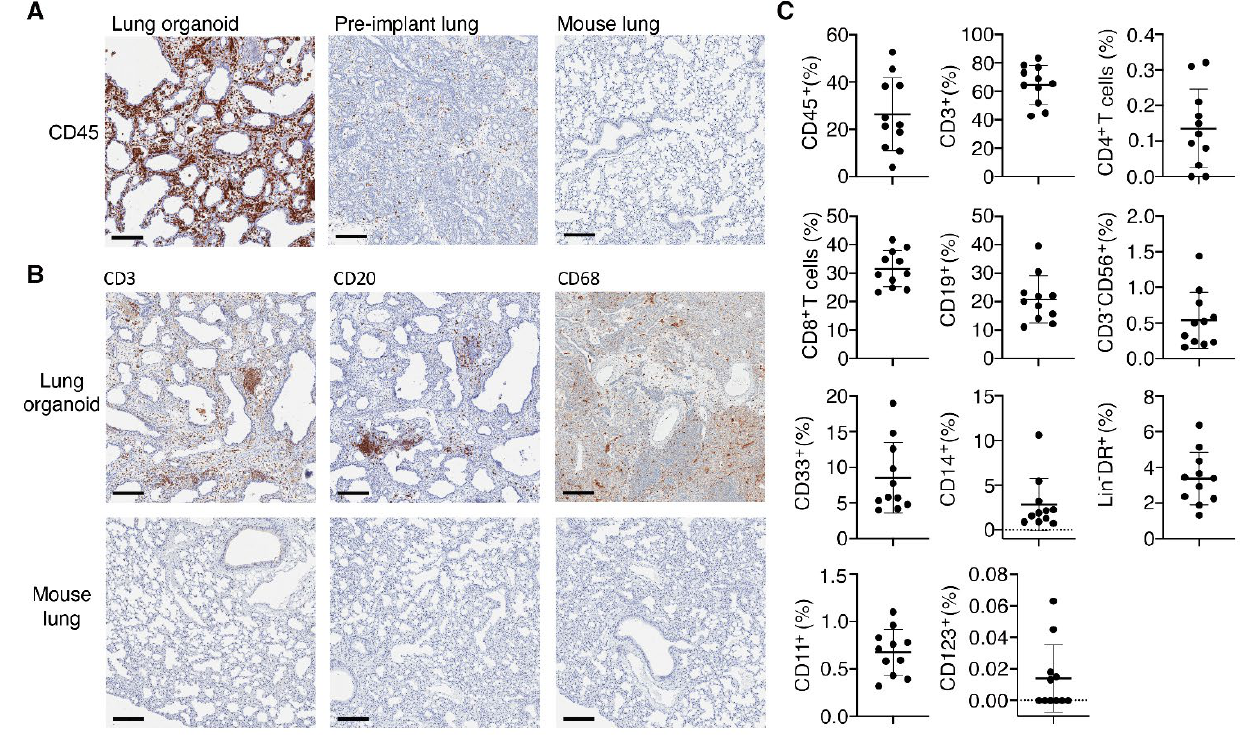
Figure 3. Presence of human immune cells in implanted lung organoids. ( A ) Representative im- munohistochemical (IHC) staining for CD45 + human immune cells in lung organoids implanted on human immune reconstituted mice compared to pre-implant lung tissue. A mouse lung from a non- humanized TKO mouse served as a control for human specificity of the antibody. ( B ) Representative IHC stains for the presence of human T cells (CD3), B cells (CD20) and macrophages (CD68) in lung organoids on TKO-BLT-L mice. Mouse lung tissue serves as a negative staining control. 15 wps ( n = 2), positive staining (brown), ×10 magnification, scale bars, 200 μm. ( C ) Flow cytometric analysis of immune cells isolated from lung organoids between 20- and 25-weeks post-surgery. Frequencies were determined for total human leukocytes (hCD45 + ) cells, myeloid cells (CD33 + ), B cells (CD19 + ), CD4 + and CD8 + as well as total T cells (CD3 + ), monocytes (CD14 + ), NK cells (CD3 - CD56 + ), total (Lin - DR hi ) DC and myeloid (CD11c + ) and plasmacytoid (CD123 + ) DC subsets. Each dot represents an in- dividual lung implant ( n = 11 implants). Horizontal lines represent mean ± SD. Each cell type is expressed as the frequency of human leukocytes except for CD45 cells, which was calculated from the live cell gate and CD4 + and CD8 + cells, which are expressed as frequency of CD3 + T cells. To more extensively assess the human immune cell complement in the lung organoids we performed flow cytometric analysis on leukocytes isolated from the lung organoids of 20–25 wps TKO-BLT-L mice produced from two different human donors (Figure 3C). The lung organoids contained the same immune cell types found in the peripheral blood of TKO-BLT-L mice. Frequencies were determined in lung organoids for total CD45 + human leukocytes (26.31 ± 15.42), CD33 + myeloid cells (8.53 ± 4.96), CD19 + B cells (20.80 ± 8.37), total CD3 + T cells (64.69 ± 13.53) and each subset within including CD4 + (0.14 ± 0.11) and CD8 + (31.50 ± 6.39) T cells, CD14 + monocytes (2.82 ± 2.91), CD3 - CD56 + NK cells (0.54 ± 0.39), total Lin - DR hi DC (3.38 ± 1.48) and each subset within including CD11c + myeloid (21.83 ± 6.94) and CD123 + plasmacytoid (0.29 ± 0.38) DC (Figure 3C). The immune cell subsets in a 59-year-old female adult human lung sample were also evaluated as a reference (Table 2). Interestingly, similarly low frequencies of hCD45 (11%) and CD4 + T cells (0.46%) were observed in the adult human lung as in the TKO-BLT-L lung